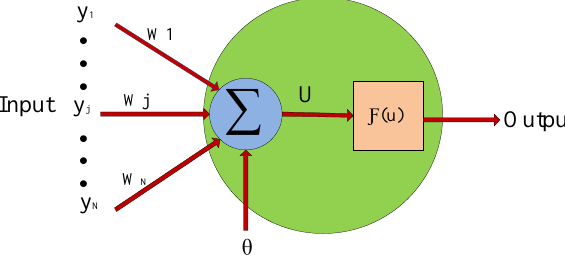
Figure 10. A general structure of a neuron and a networked interconnection.